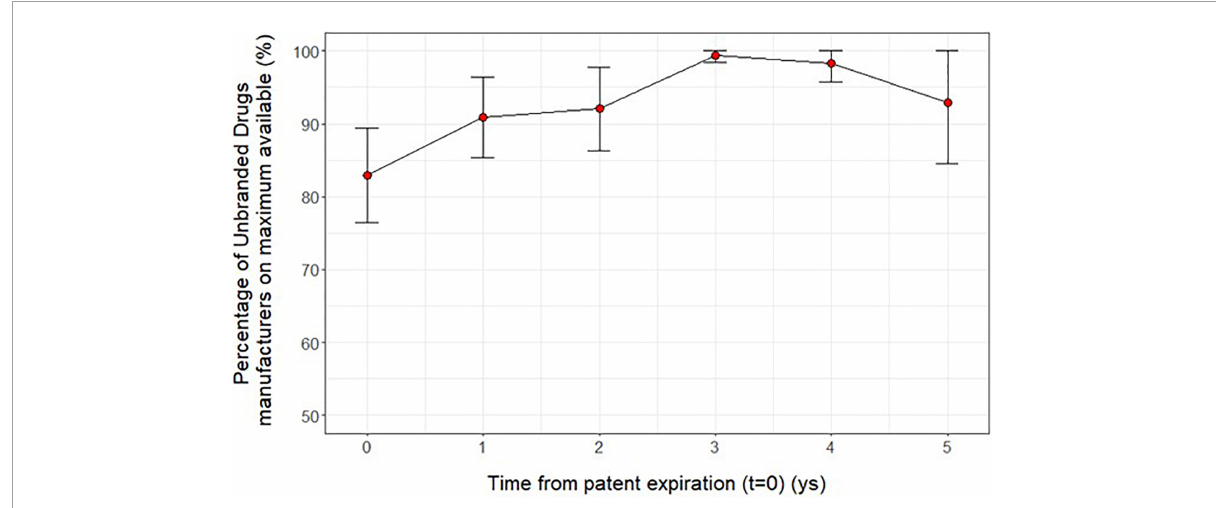
FIGURE4 Average ratio (mean and 95 % CI) between the number of unbranded manufacturers over the maximum number observed for each active ingredient (5th level ATC) by time from patent expiration ( t = 0 − 5).